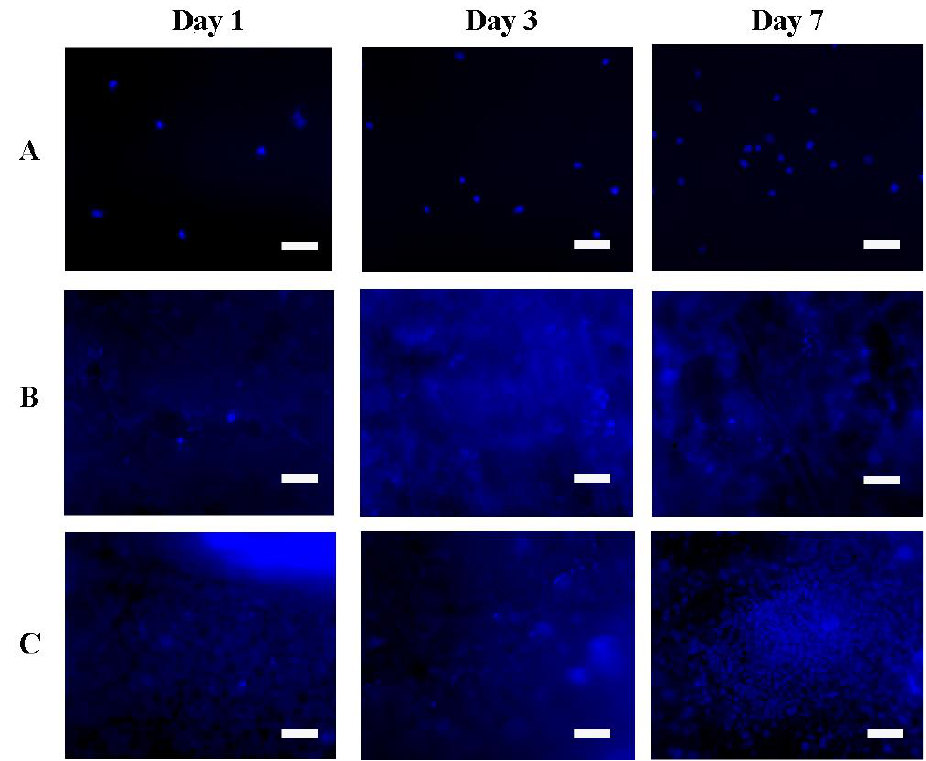
Figure 7. Images of 3T3 mouse fibroblast cells cultured on the obtained scaffolds. The scale bar is 100 µm. Cell nuclei are stained with DAPI. ( A ) control (cultural plastic), ( B ) SF scaffold, ( C ) SF-MP scaffold.